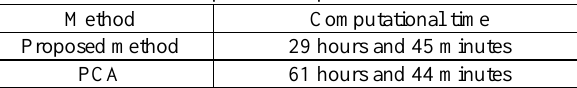
Table 12. Computational speed of two